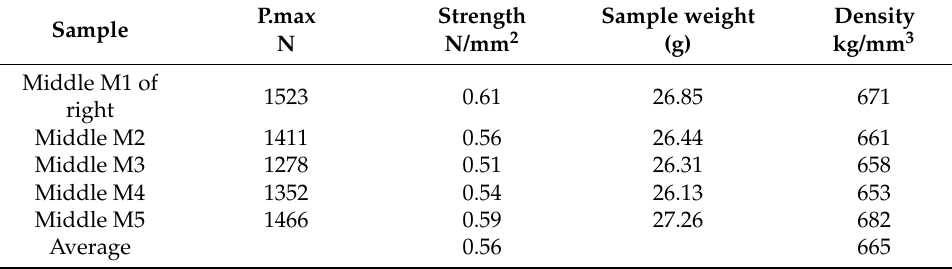
Table 6. Internal bonding test